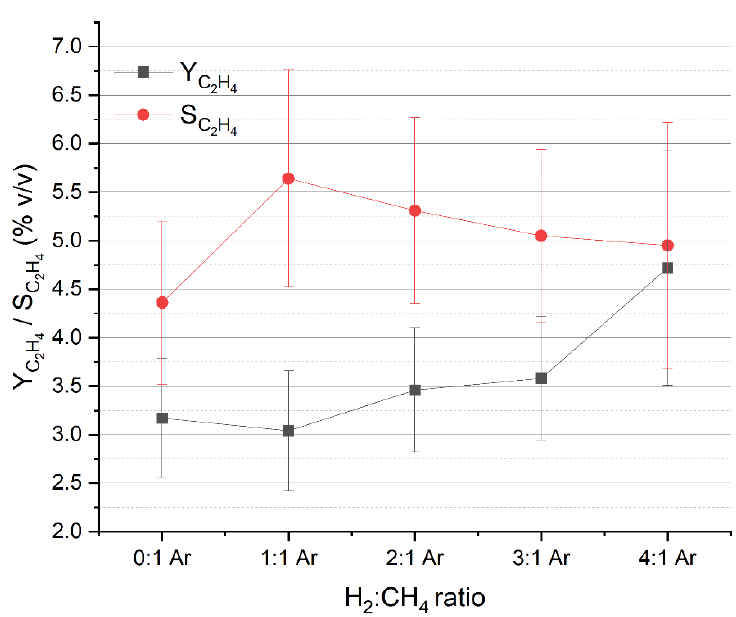
Figure 3. H 2 impact on C 2 H 4 selectivity and yield.